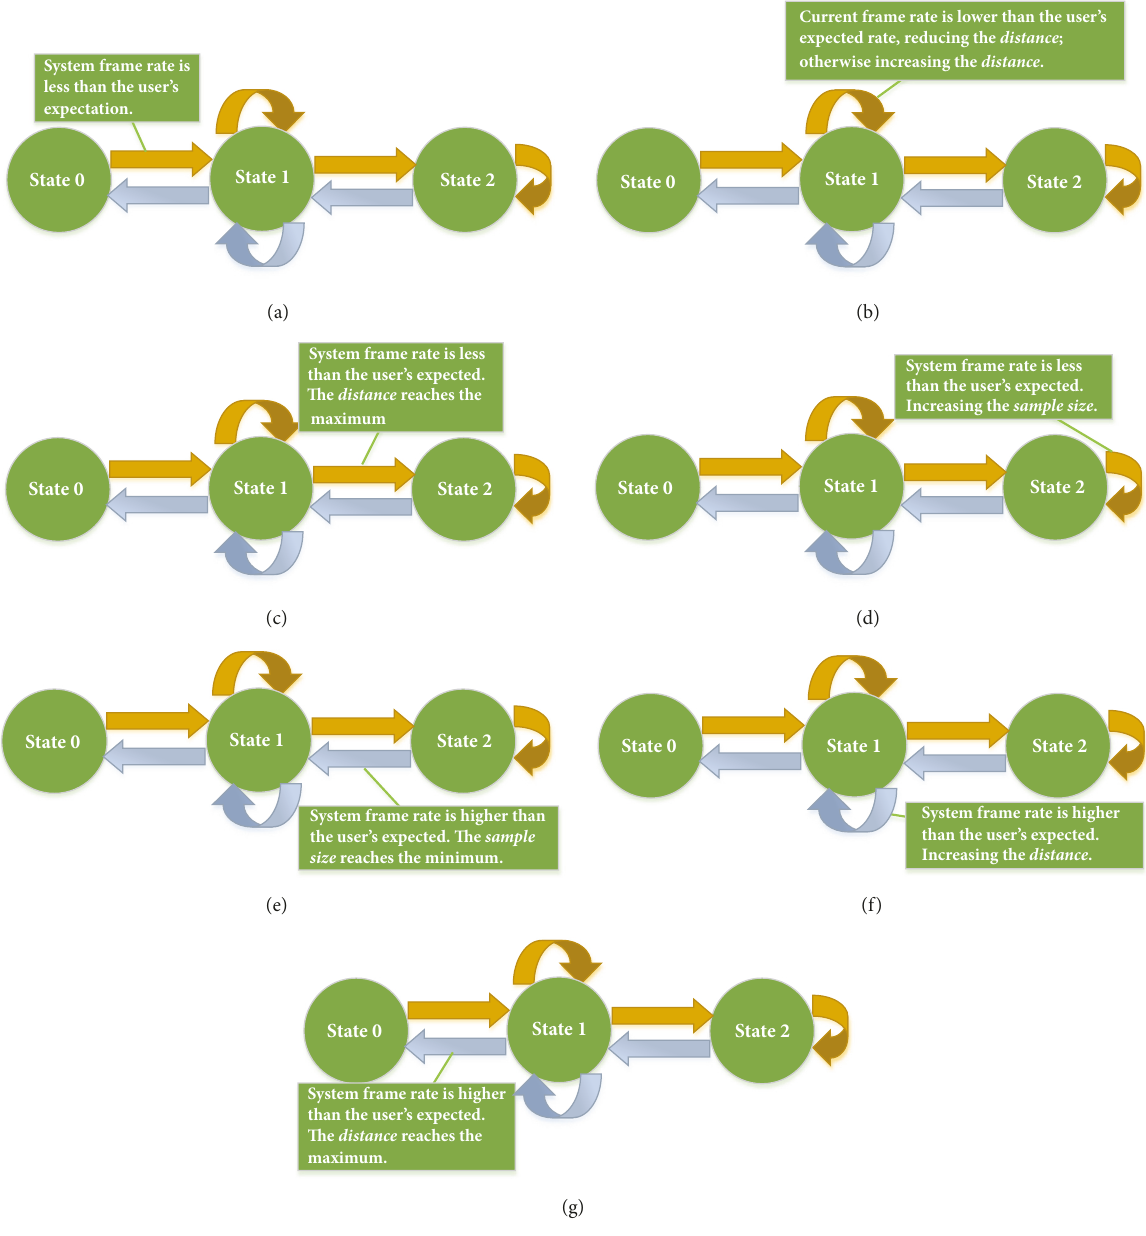
Figure 5: State transition mechanism of state